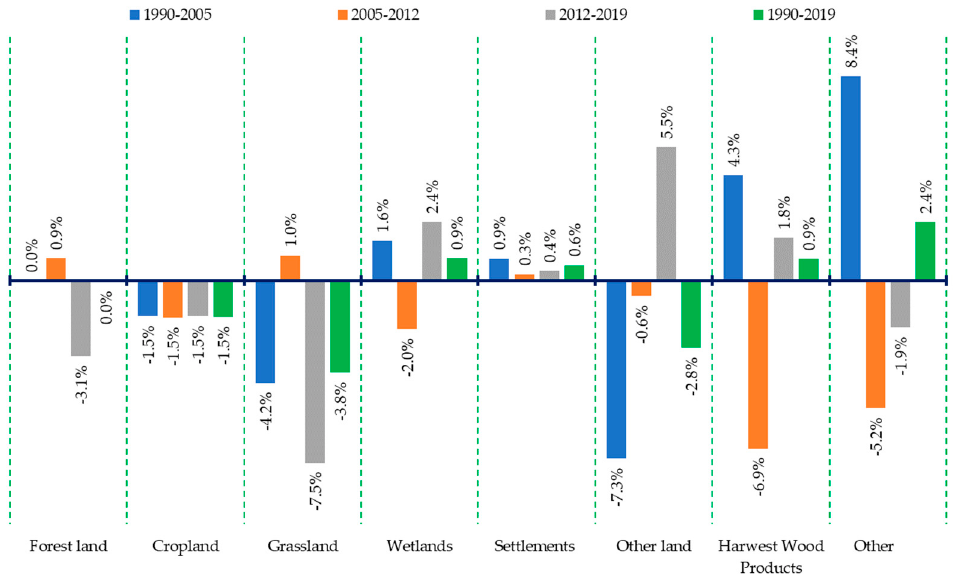
Figure 3. The GHG emissions/removals dynamics, by land use, EU-27 + UK. GHG emissions from the Settlements increased by 20% in 2019 compared to